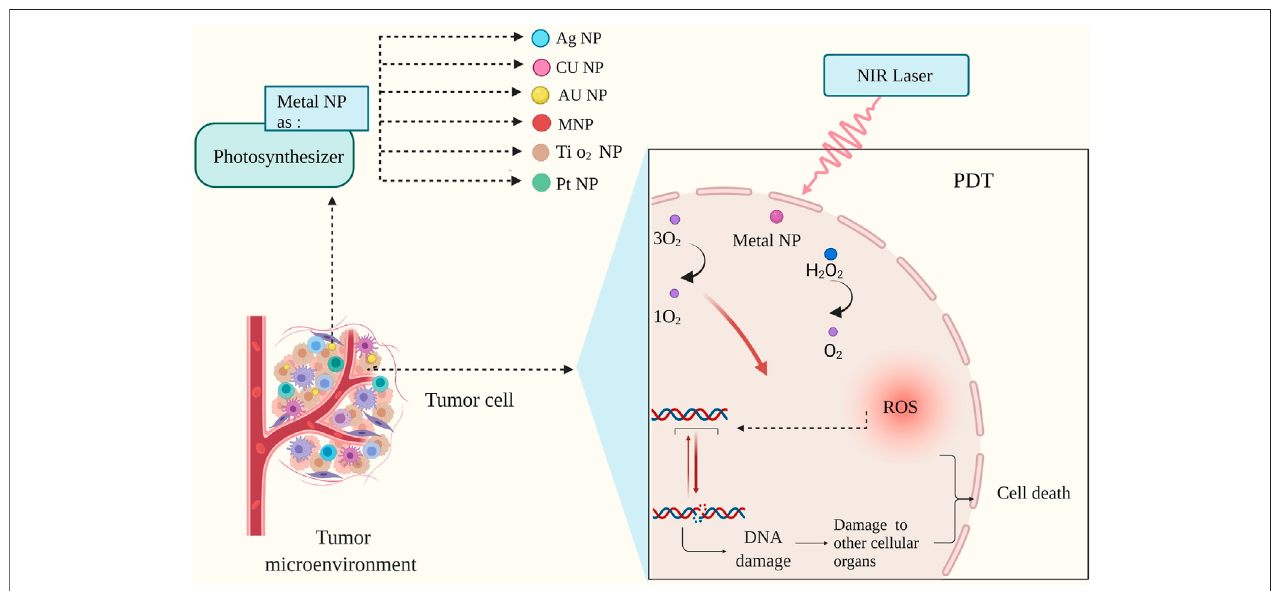
FIGURE 4 | Mechanism of photodynamic therapy (PDT) with metal nanoparticles. During photodynamic therapy, nanoparticles increase oxygen production; This increase in cell oxygen production is associated with damage to nucleic acid, and the cascade created by the nanoparticles leads tumor cells to planned death (Liang et al., 2018; Yang et al.,